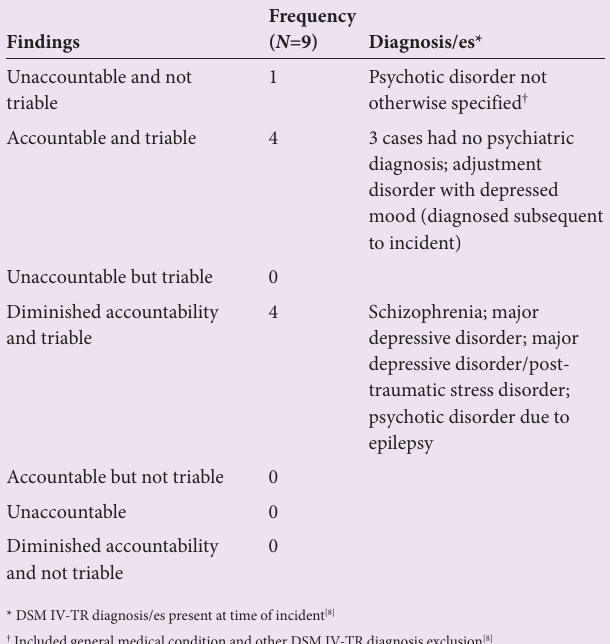
Table 1. Findings in terms of sections 77 and/or 78 of the Criminal Procedure Act 51 of 1977